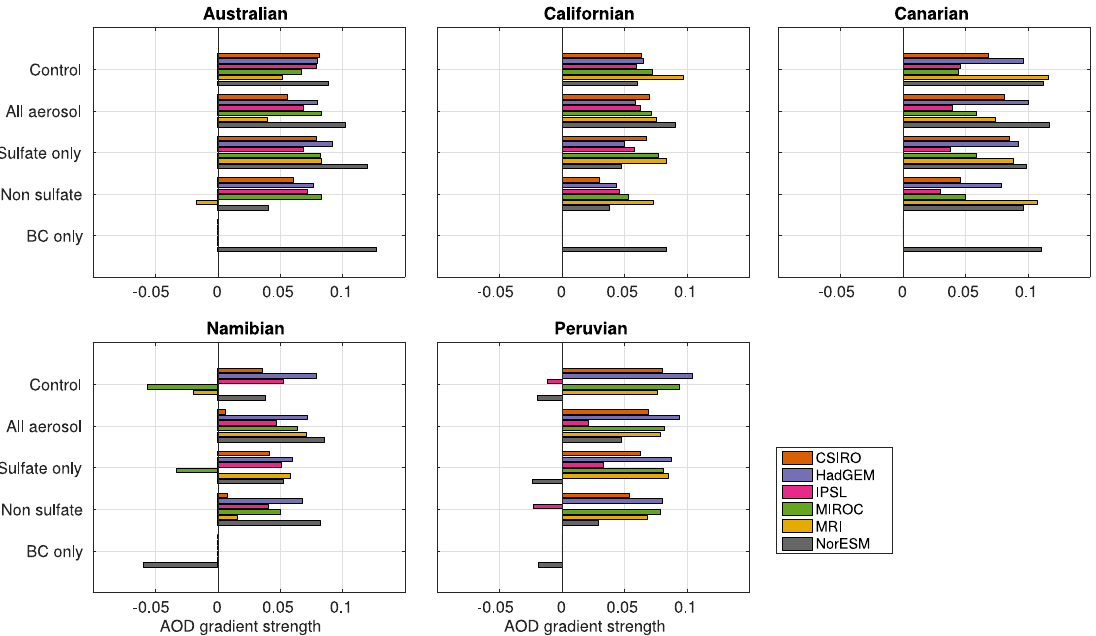
Figure 5. AOD gradient strength quantified by the difference of separate linear regressions for the lower and upper 10th percentiles of AOD anomaly points, respectively. Values are given for all six CMIP5 models for the Australian, Californian, Canarian, Namibian, and Peruvian regions and the control, all-aerosol, sulfate-only, non-sulfate, and BC-only (for NorESM)